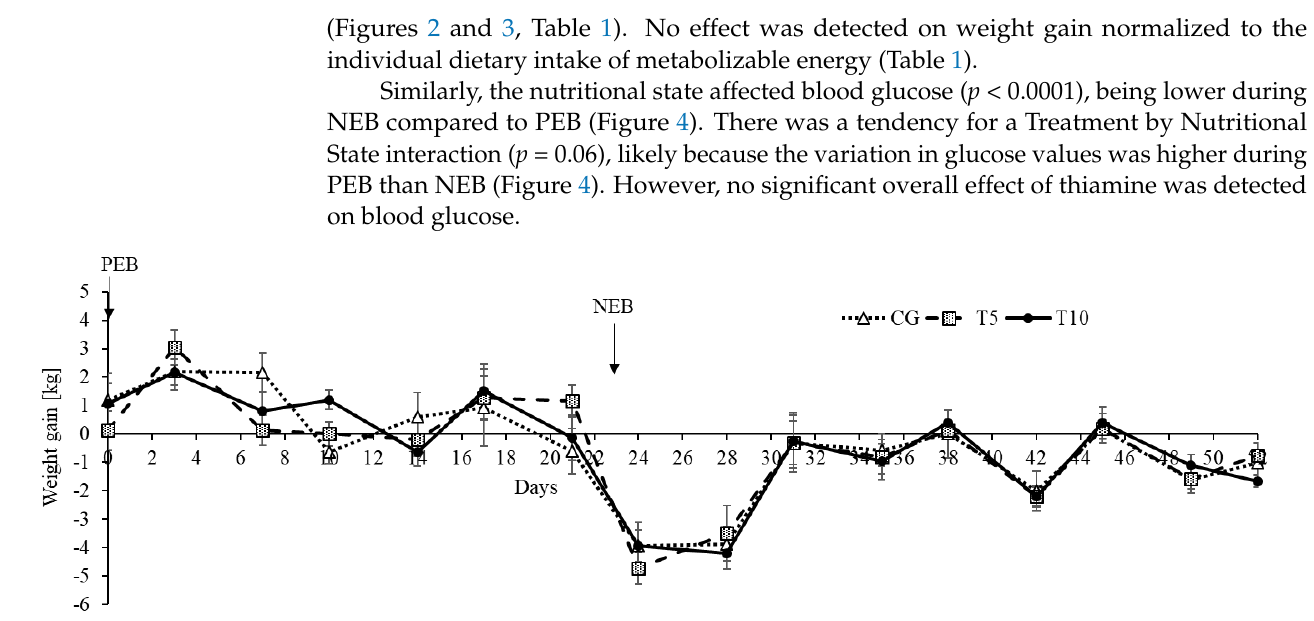
Figure 2. Weight gain response under positive (PEB) and negative (NEB) energy balance states in the control and thiamine treated groups. Effect of Treatment ( p = 0.83), nutritional state ( p < 0.0001), time ( p < 0.0001), and Treatment by Nutritional State interaction ( p = 0.94). CG: Control, T5: Thiamine treatment at 5 mg/kg, T10: Thiamine treatment at 10 mg/kg.